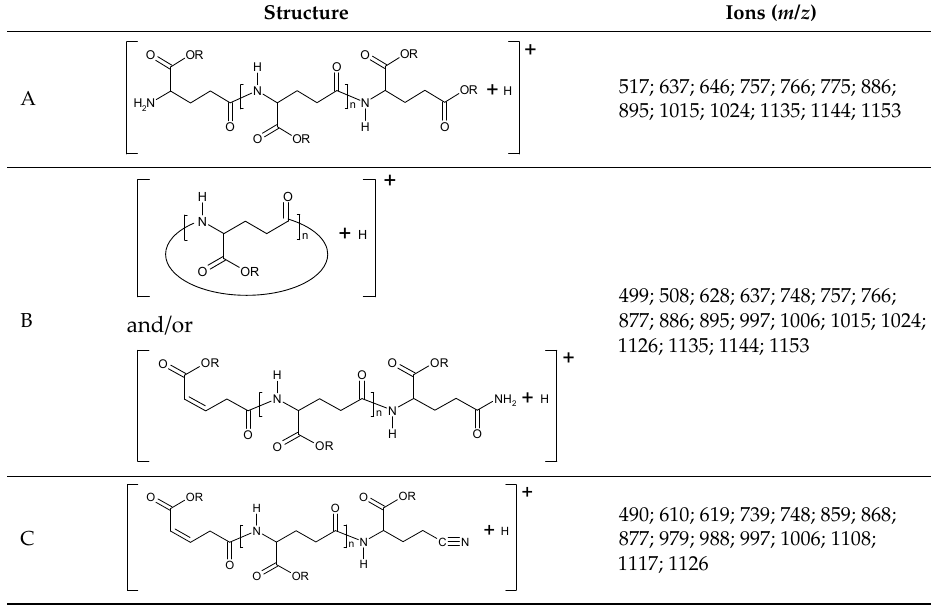
Table 2. Structural assignments of the most intensive ions appearing in the expanded regions at m / z 480–800 and 840–1040 of the ESI–MS spectrum. Structure Ions ( m / z )